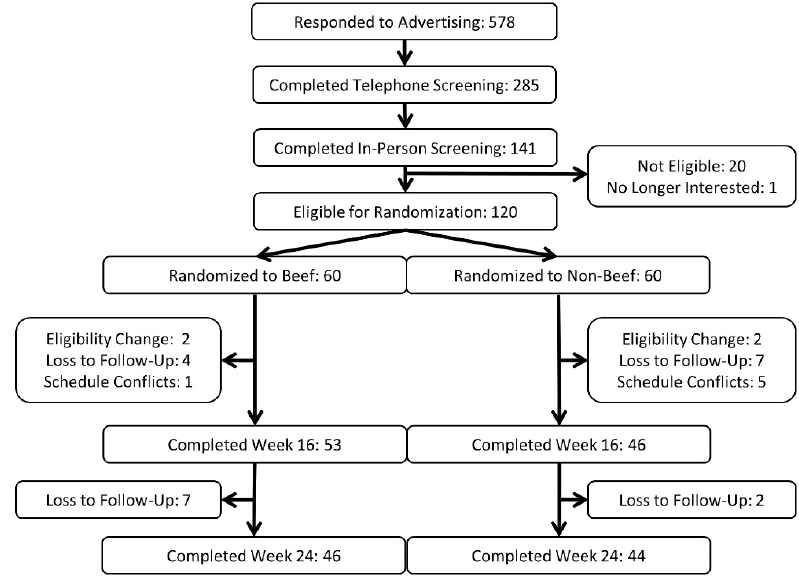
Figure 1. Study recruitment and flow diagram. Table 1. Baseline participant characteristics 1 .